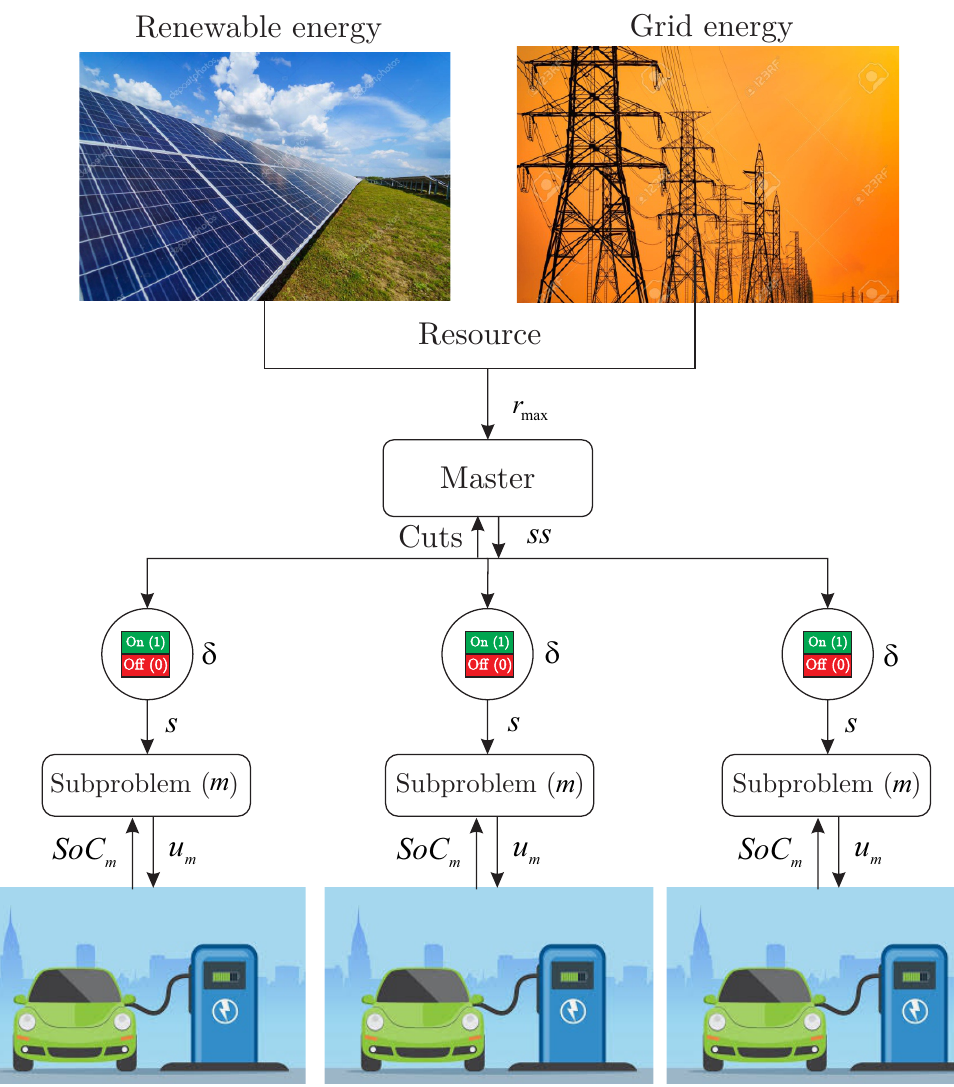
Figure 6. Distributed MPC for electric vehicle battery